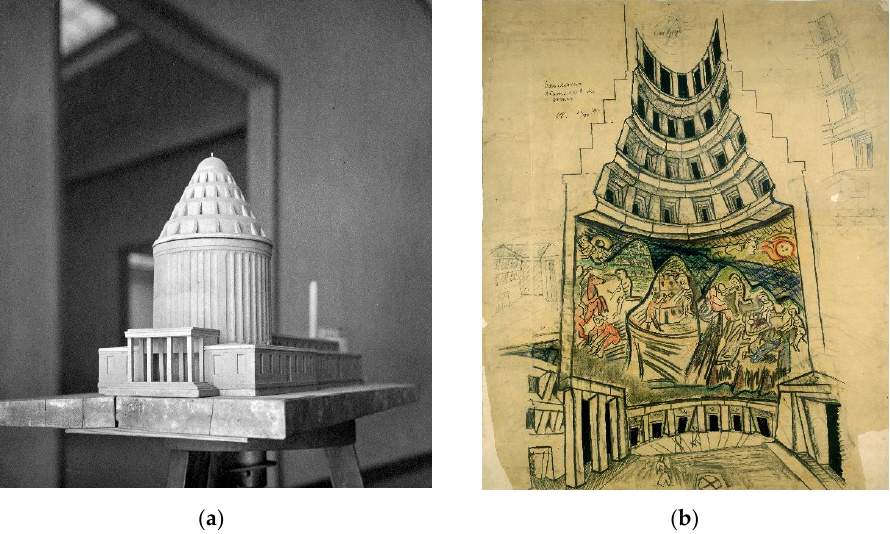
Figure 14. The crematorium design by Max Berg: ( a ) model (Deutsches Museum in Munich); ( b ) painting decoration design by Oscar Kokoschka, 26 November 1914 (Staatlichen Kunstsammlungen Dresden, after http://www.7cudow.eu/pl/eksponaty/max-berg-oskar-kokoschka-niezrealizowany- projekt-krematorium-na-cmentarzu-grabiszynskim/, accessed on 27 November